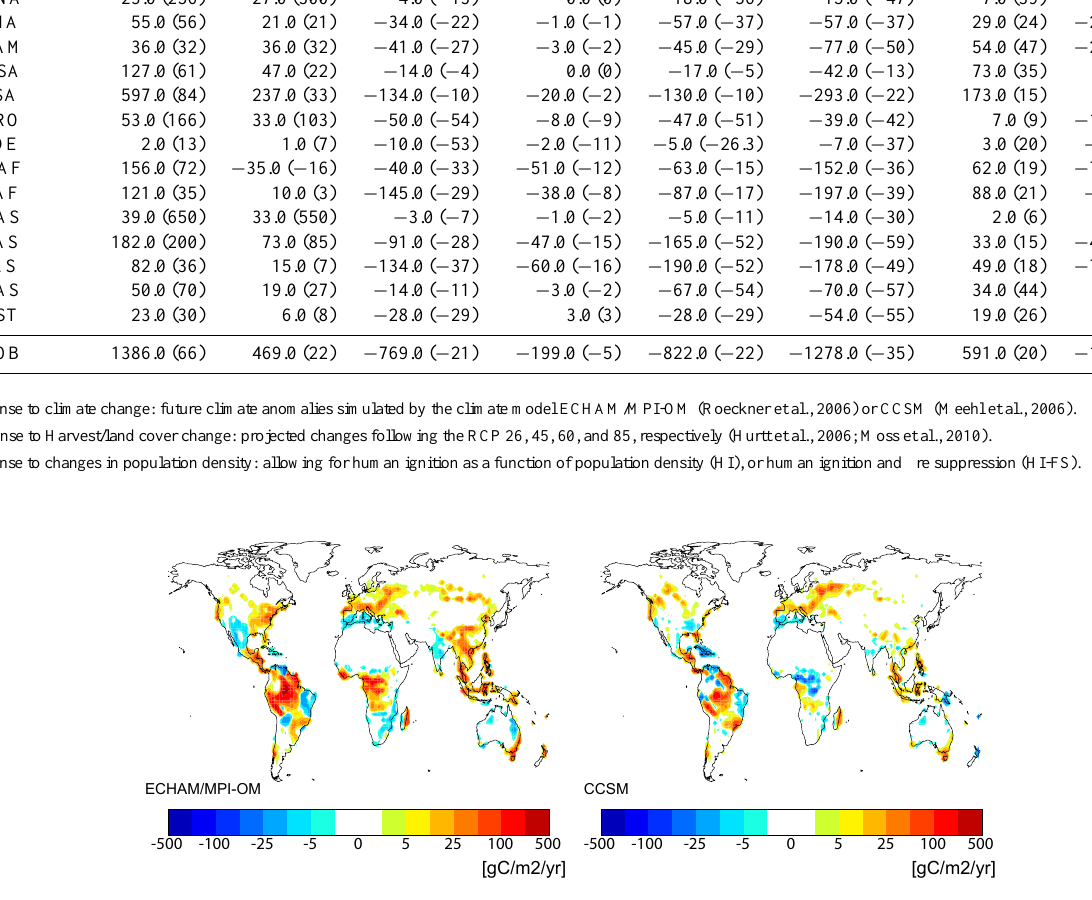
Fig. 4. Change in annual mean fire emissions in [gC/(m 2 yr)] averaged over 2075–2099 introduced by changes in climate. Simulations with transient varying forcings are compared to a control simulation in which the forcing is kept constant at preindustrial level. Left side: ECHAM/MPI-OM A1B (Roeckner et al., 2006) future climate forcing (AB-45-E1 minus AB-45-CLIM); Right side: CCSM A1B (Meehl et al., 2006) future climate forcing (AB-45-C1 minus